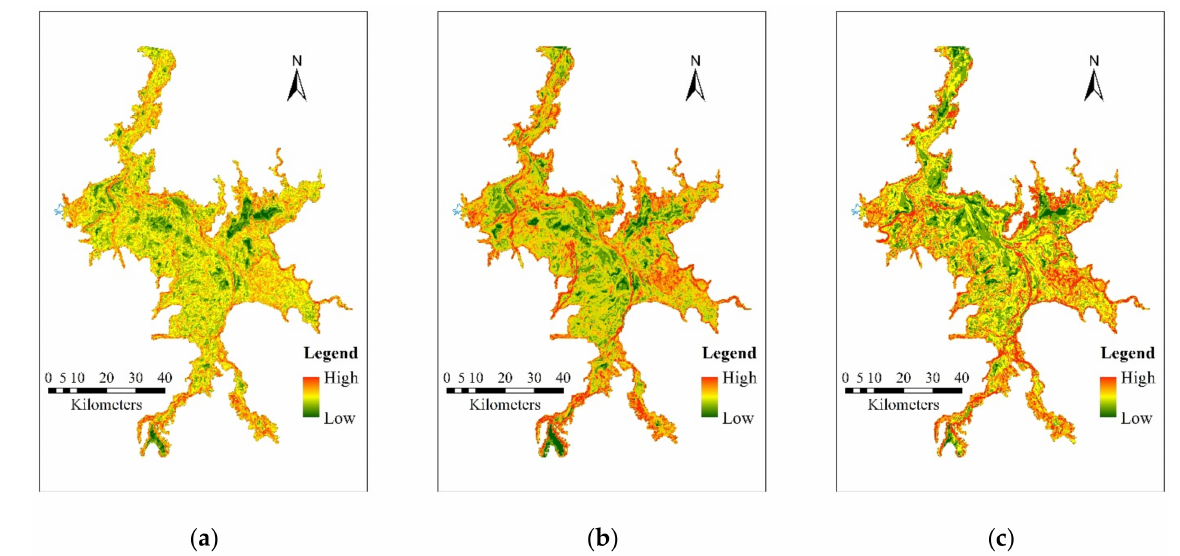
Figure 8. Varieties of crane habitats in the Poyang Lake wetland under different hydrological conditions: ( a ) EL, extremely low level; ( b ) LL, low level; ( c ) AL, average level. Higher values indicate stronger variety of the crane habitats. Table 6. Area statistics of stabilities and varieties of crane habitats in the Poyang Lake wetland under different hydrological conditions (km 2